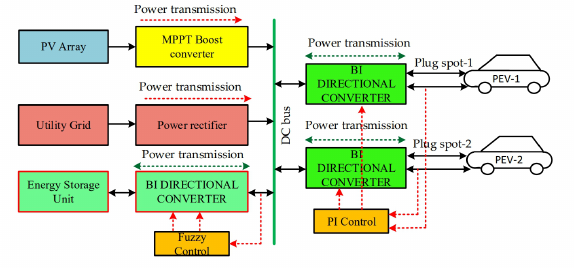
Fig. 1. Block Diagram of charging infrastructure.